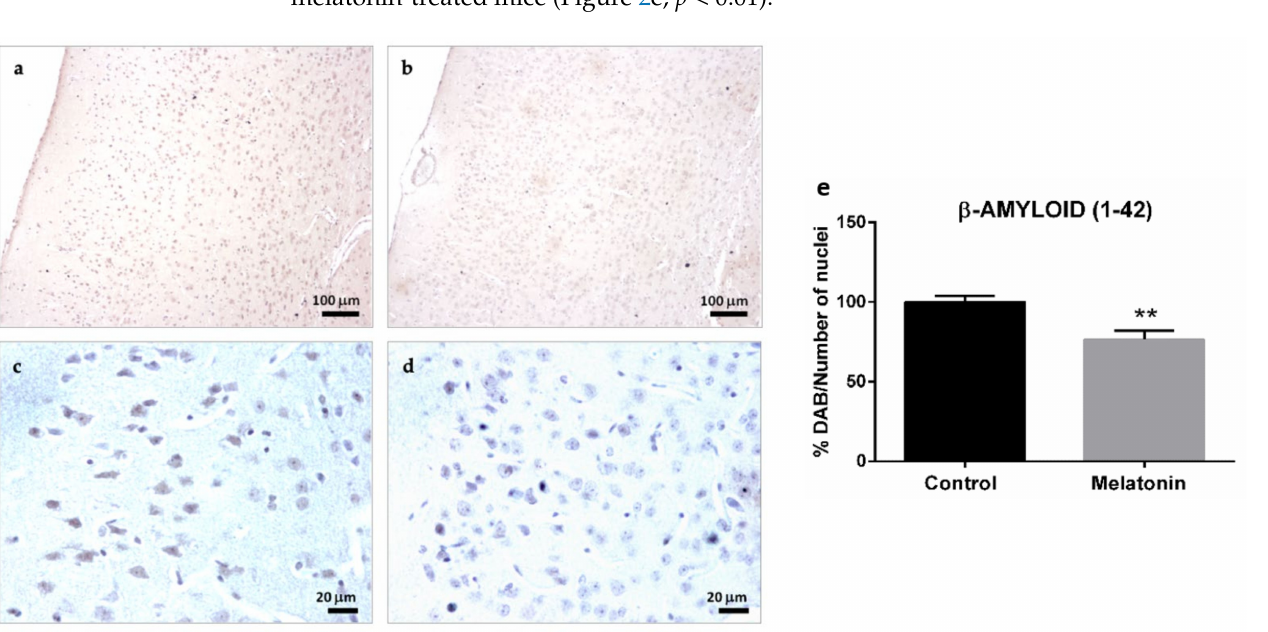
Figure 2. β -Amyloid (1-42) immunostaining in the cortex of SAMP8 control mice ( a , c ) and SAMP8 mice treated with melatonin ( b , d ). Bar chart ( e ) shows quantification of the DAB signal with respect to the total number of nuclei at 400 × magnifications (in percentages with respect to the control). Data are expressed as means ± SEM. ** p < 0.01 vs. control. Statistical analysis was always performed in 10 images obtained from each control mice ( n = 4) and mice treated with melatonin ( n =